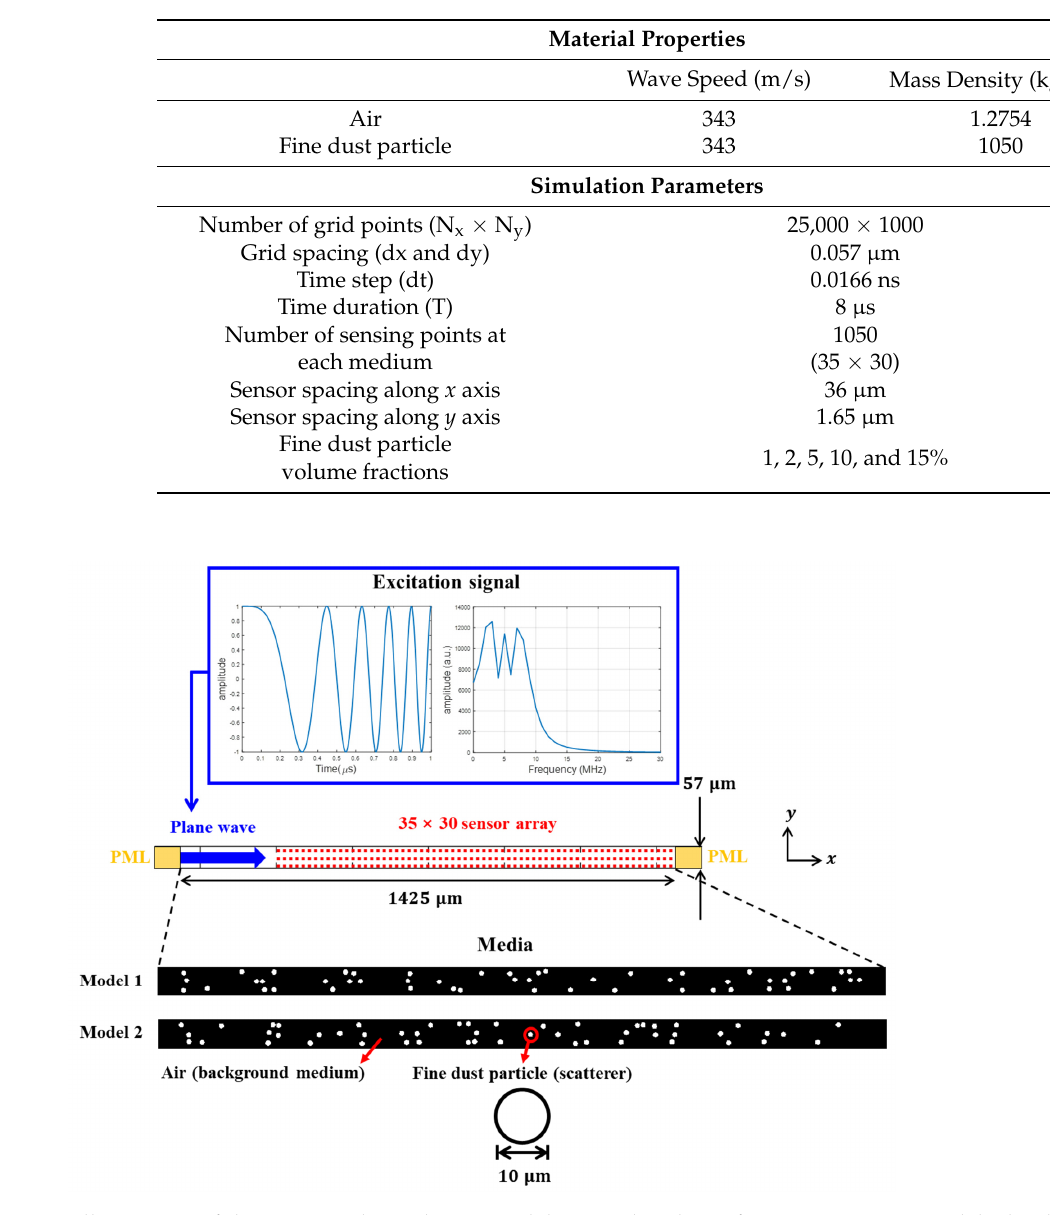
Table 1. Summary of the numerical simulation parameters.